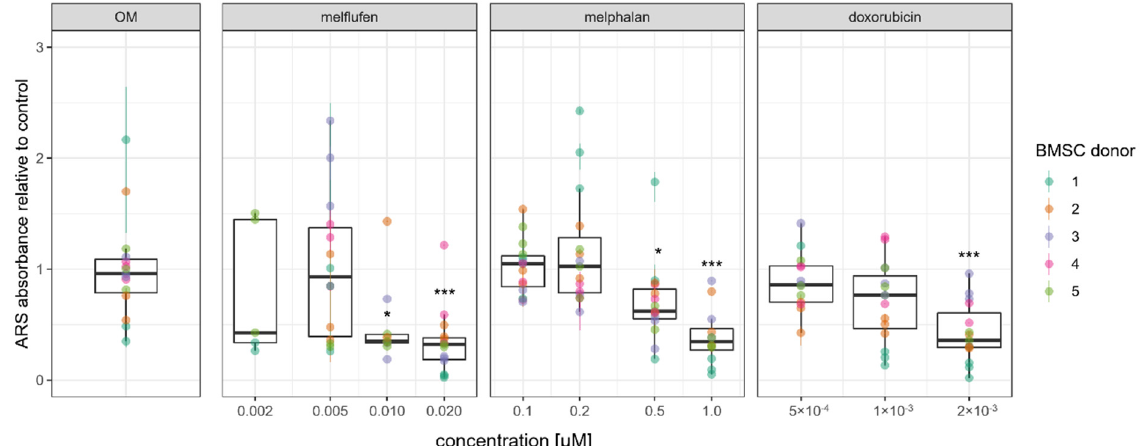
Figure 10. Mineralized matrix formation by osteogenically differentiated BMSCs in the presence of drugs. Quantification of the Alizarin Red S (ARS) stainings presented relative to the control. Dots represent individual culture wells with a color-coded donor cell line. * denotes p < 0.05 and *** denotes p < 0.001 with Dunn’s test.